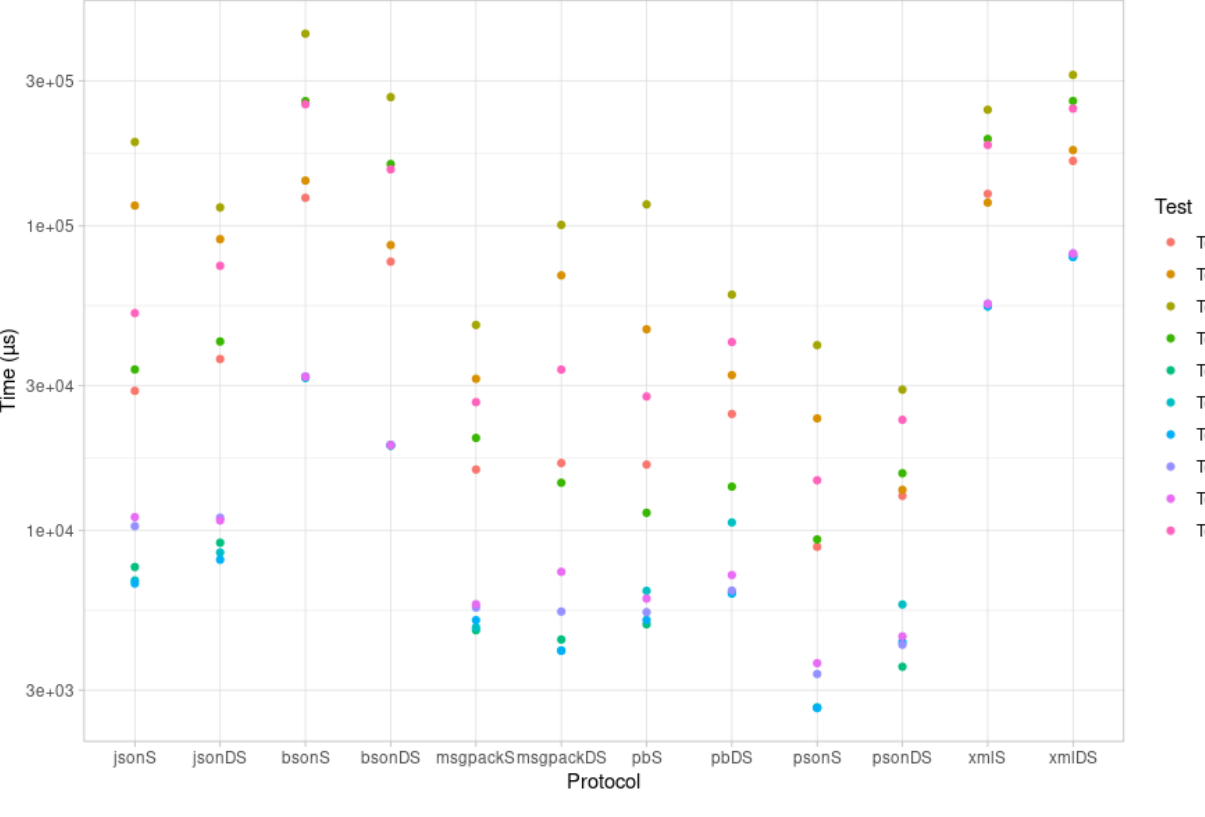
Figure 3. ESP32 Serialization (S)/Deserialization (DS)